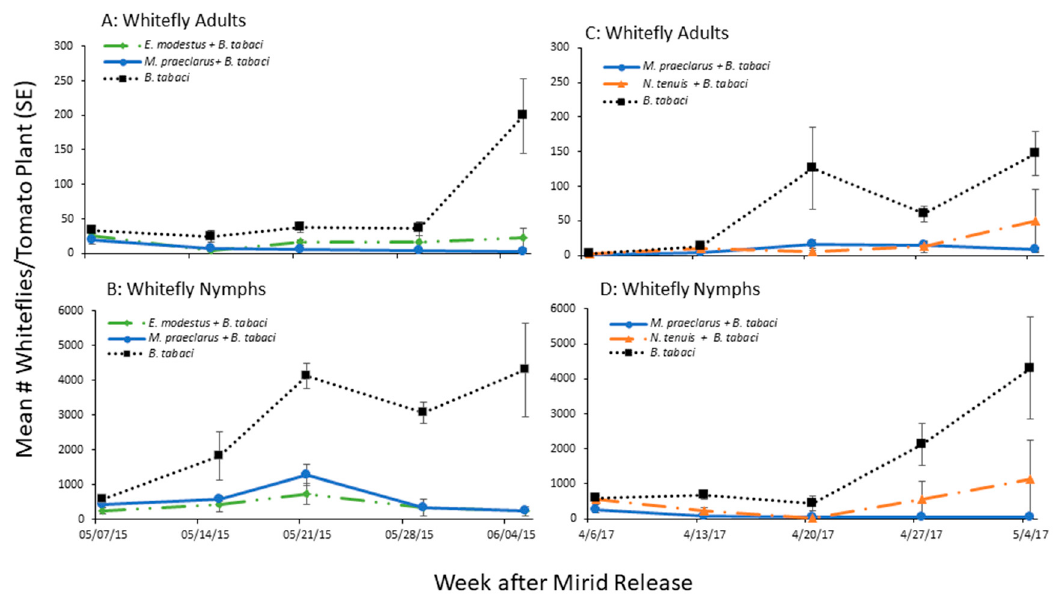
Figure 1. Mean (±SE) number of adult and nymph whiteflies ( Bemisia tabaci ) found on tomato plants in two 5 week field cage studies with three different mirid predators. Experiment 1 ( A and B ) compared whitefly population growth in cages with no predators ( B. tabaci ) and with predators Macrolophus praeclarus ( M. praeclarus + B. tabaci ) or Engyatus modestus ( E. modestus + B. tabaci ). Experiment 2 ( C and D ) compared whitefly population growth in cages with no predators ( B. tabaci ) and with predators Macrolophus praeclarus ( M. praeclarus + B. tabaci ) or Nesidiocoris tenuis ( N. tenuis + B. tabaci ). Table 1. The result of the analysis of variance showing main effects and interactions on the total number of whitefly ( Bemisia tabaci [ B.t. ]), mirids ( Macrolophus praeclarus [ M.p. ], Engytatus modestus [ E.m. ] and Nesidiocoris tenuis [ N.t. ]), and mirid damage to tomato plants (Necrotic Rings). Experiment Source